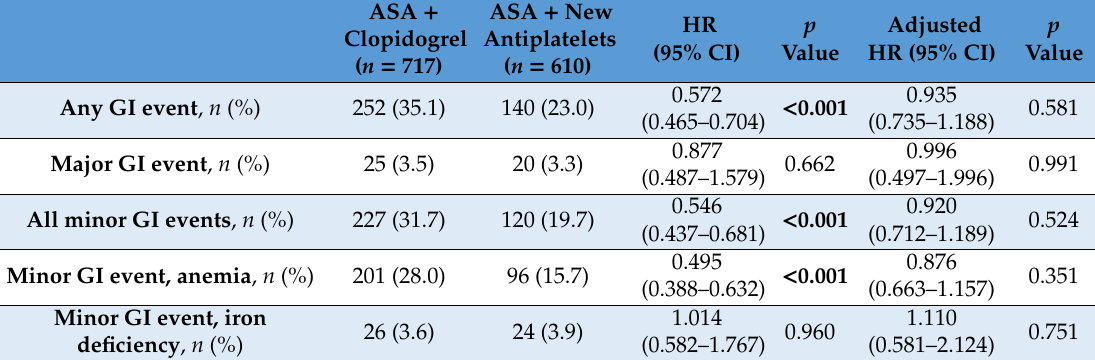
Table 2. Adjusted risk for gastrointestinal (GI) events of dual antiplatelet therapy with new antiplatelets vs. clopidogrel.